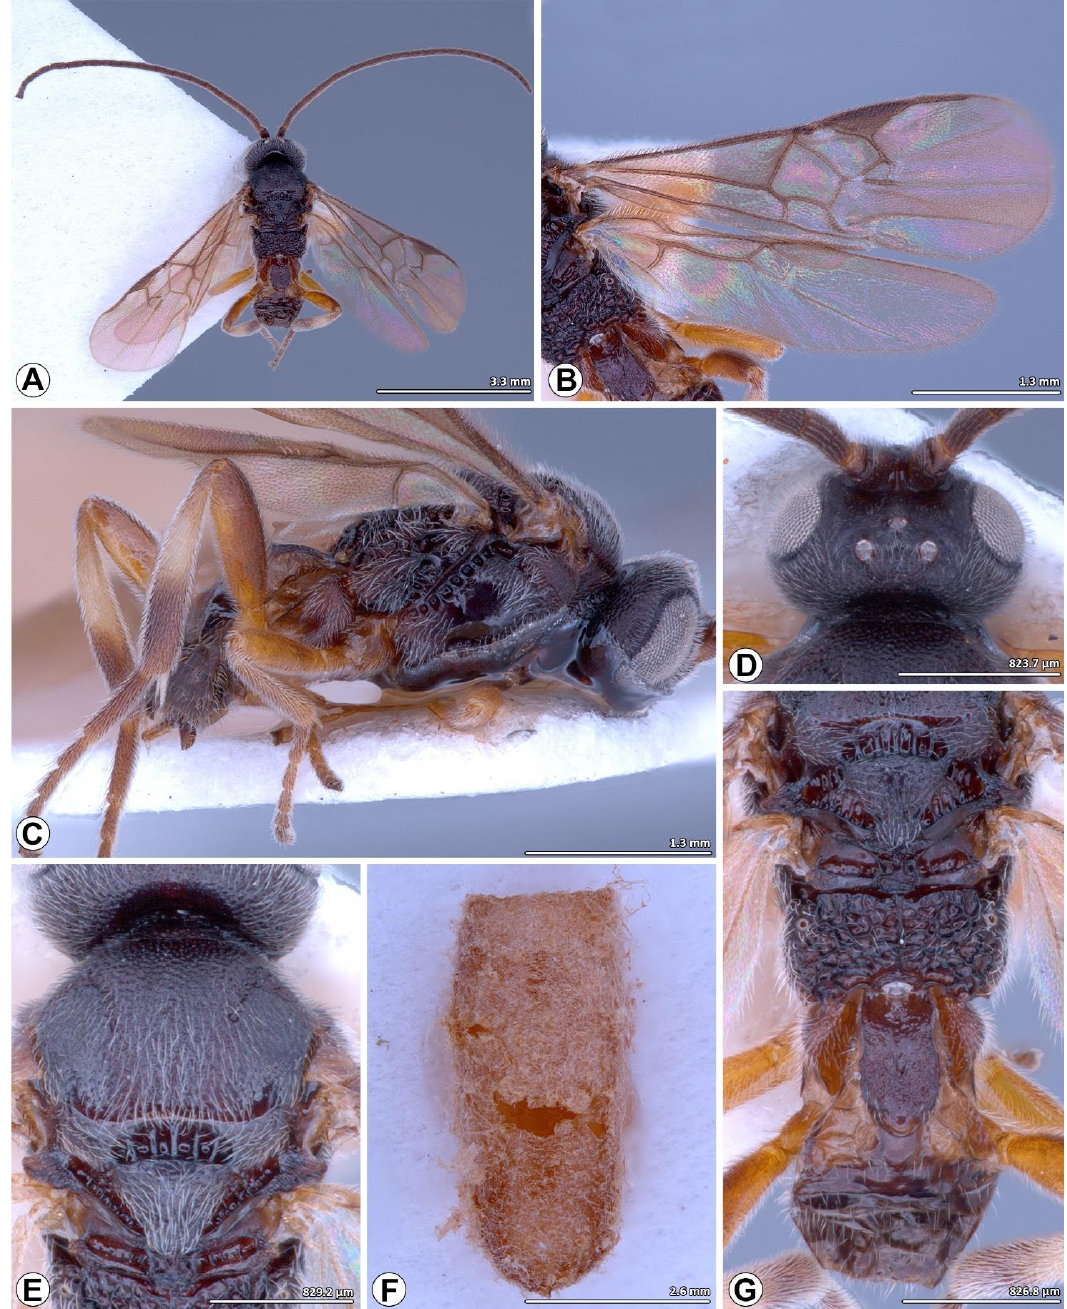
Figure 3. Microplitis manilae Ashmead, 1904, non-type male from Thailand (CUMZ). ( A , C ) Habitus; ( A ) dorsal view; ( C ) lateral view; ( B ) wings; ( D ) head, dorsal view; ( E ) mesoscutum and mesoscutellum, dorsal view; ( F ) wasp cocoon; ( G ) mesoscutellum, metanotum, propodeum, and metasoma dorsal view.